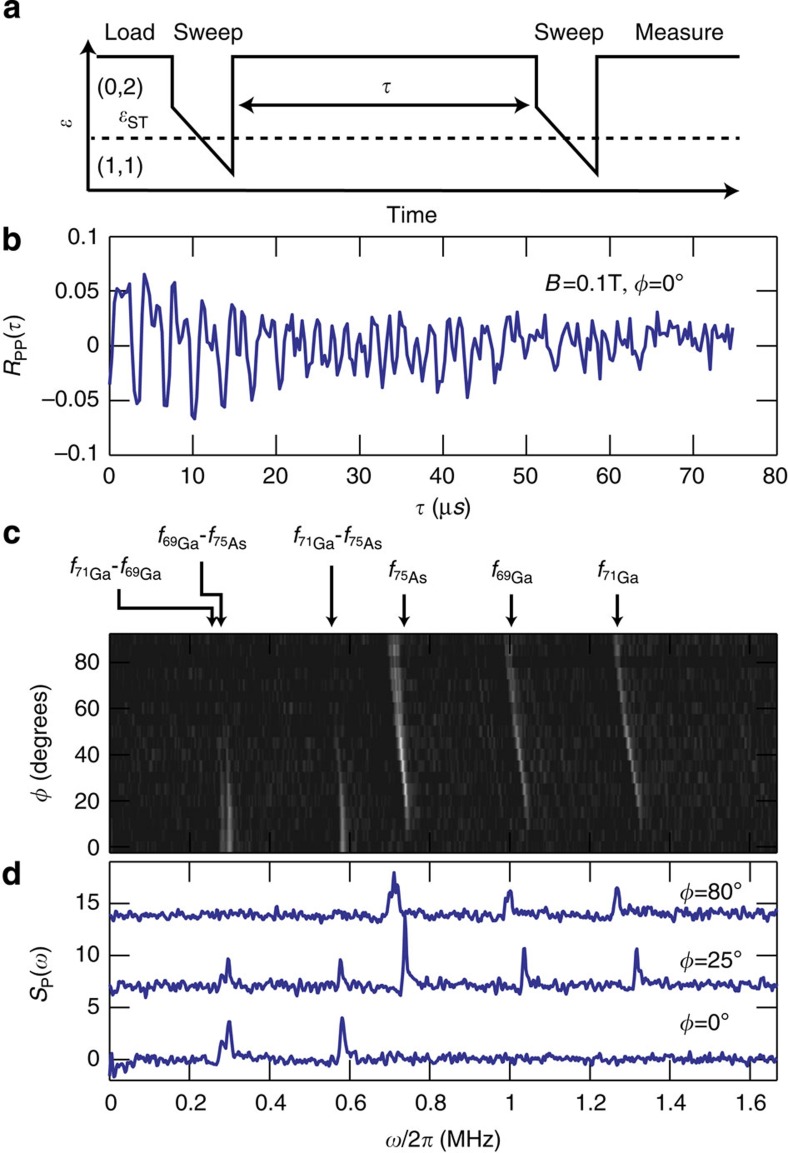
Correlations and power spectrum of PLZ(t).(a) Pulse sequence to measure RPP(τ) using two LZ sweeps. (b) RPP(τ) for ϕ=0° and B=0.1 T. The data extend to τ=200 μs, but for clarity are only shown to 75 μs here. (c) SP(ω) versus ϕ obtained by Fourier-transforming RPP(τ). At ϕ=0°, the differences between the nuclear Larmor frequencies are evident, but for |ϕ|>0°, the absolute Larmor frequencies appear, consistent with a spin–orbit contribution to σST. The reduction in frequency with ϕ is likely due to the placement of the device slightly off-centre in our magnet, and the reduction in amplitude of the difference frequencies occurs because the sweep rate β was increased with ϕ to maintain constant 〈PLZ〉 (see Methods section). (d) Line cuts of SP(ω) at ϕ=0°, 25° and 80°.